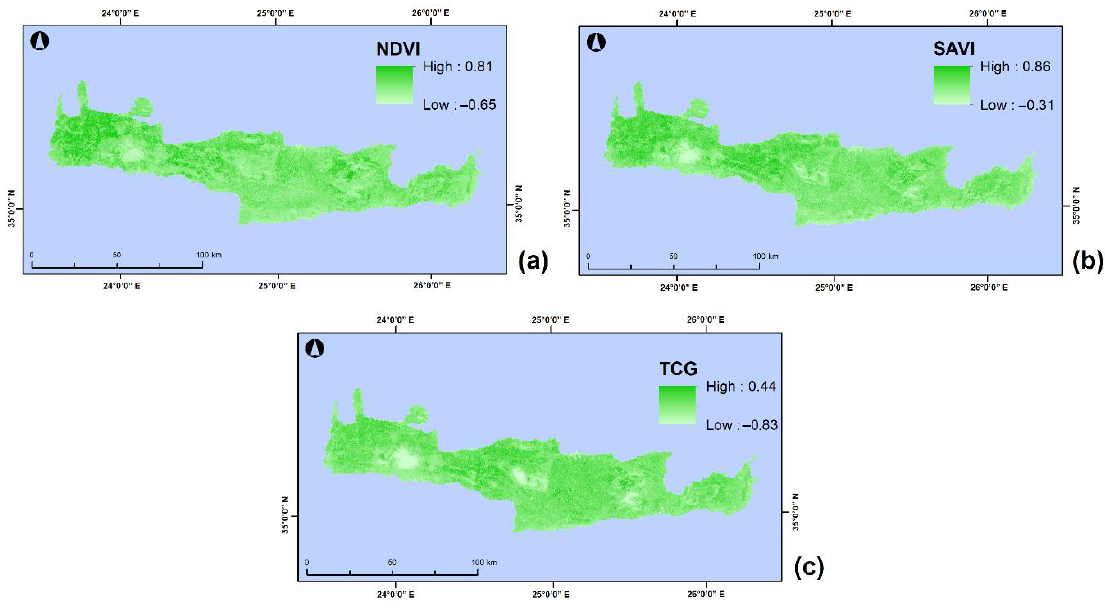
Table 1. Coefficients for tasseled cap greenness and brightness.